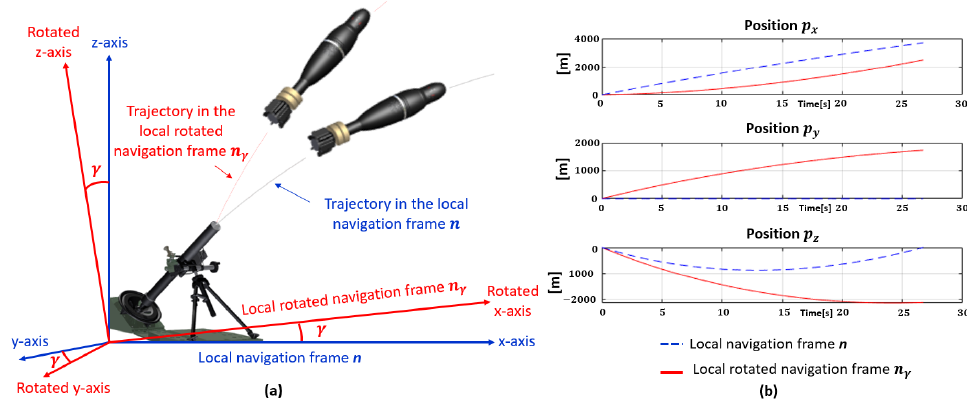
Figure 4. ( a ) Local navigation frame n and local rotated navigation frame n γ . ( b ) Projectile position in the local navigation frame n (blue dashed line), projectile position in the local rotated navigation frame n γ (red solid